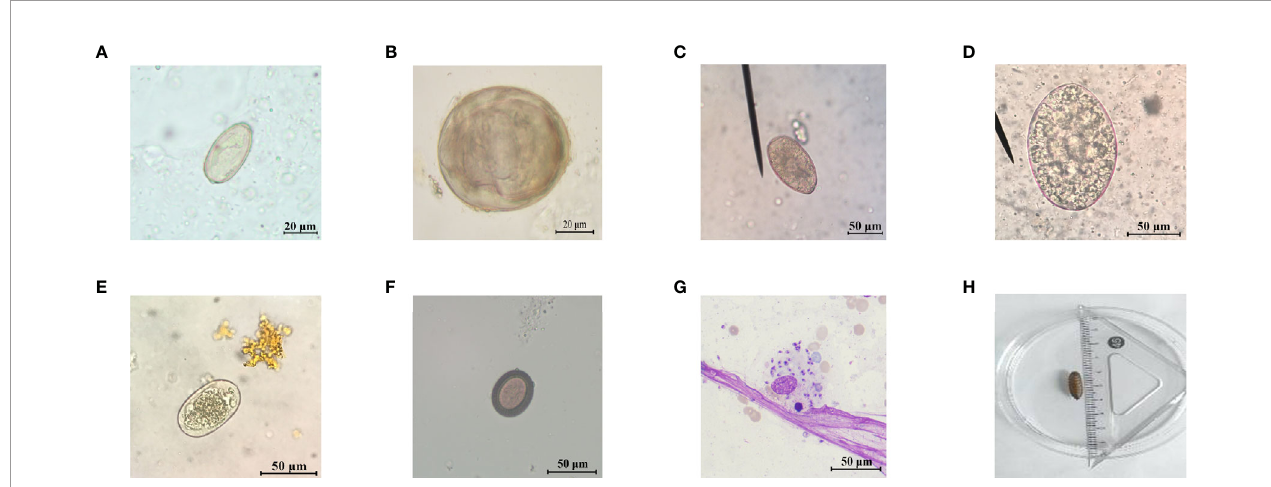
FIGURE 1 | Representative images of parasite eggs, amastigotes, and larva for etiological examination. (A) C. sinensis egg; (B) S. japonicum egg; (C) P. westermani egg; (D) F. buski egg; (E) hookworm egg; (F) Taenia egg; (G) L. donovani bodies; and (H)